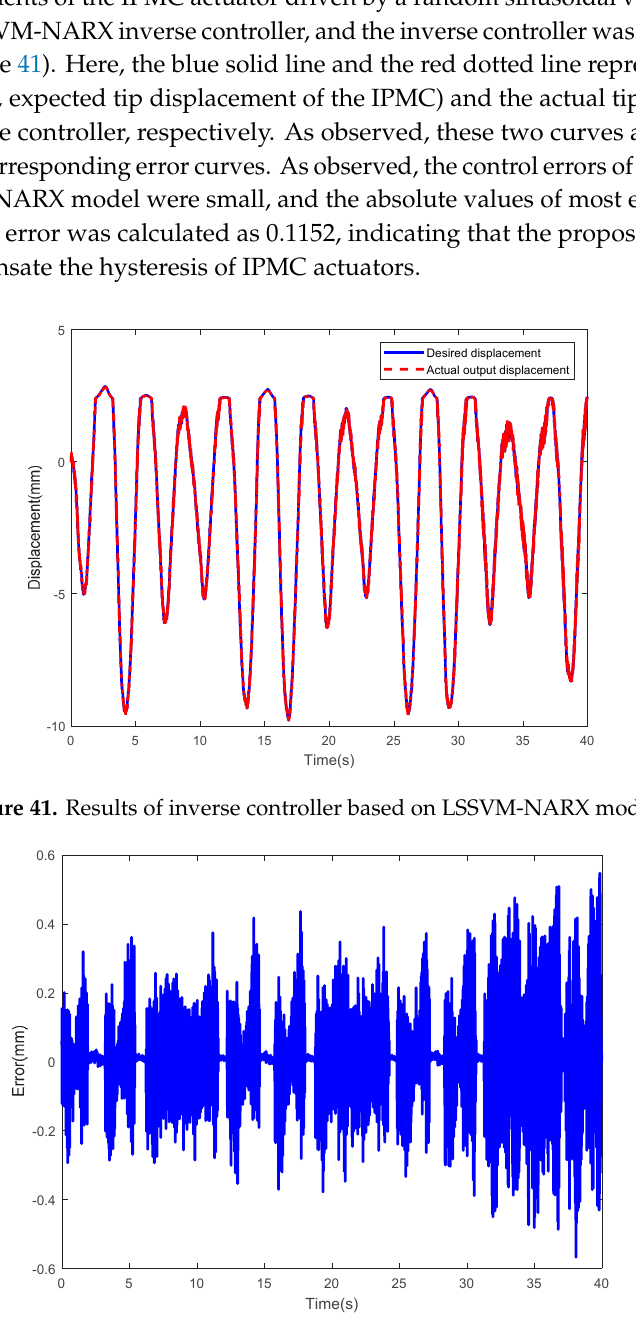
Figure 41. Error of inverse controller based on LSSVM ‐ NARX model.